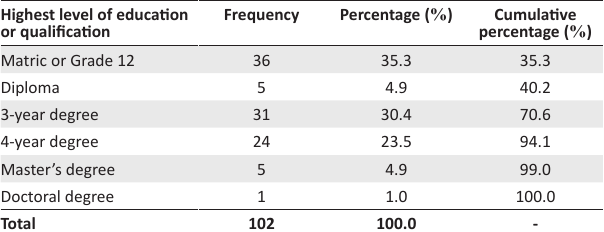
TABLE 6: Highest level of education or qualification.